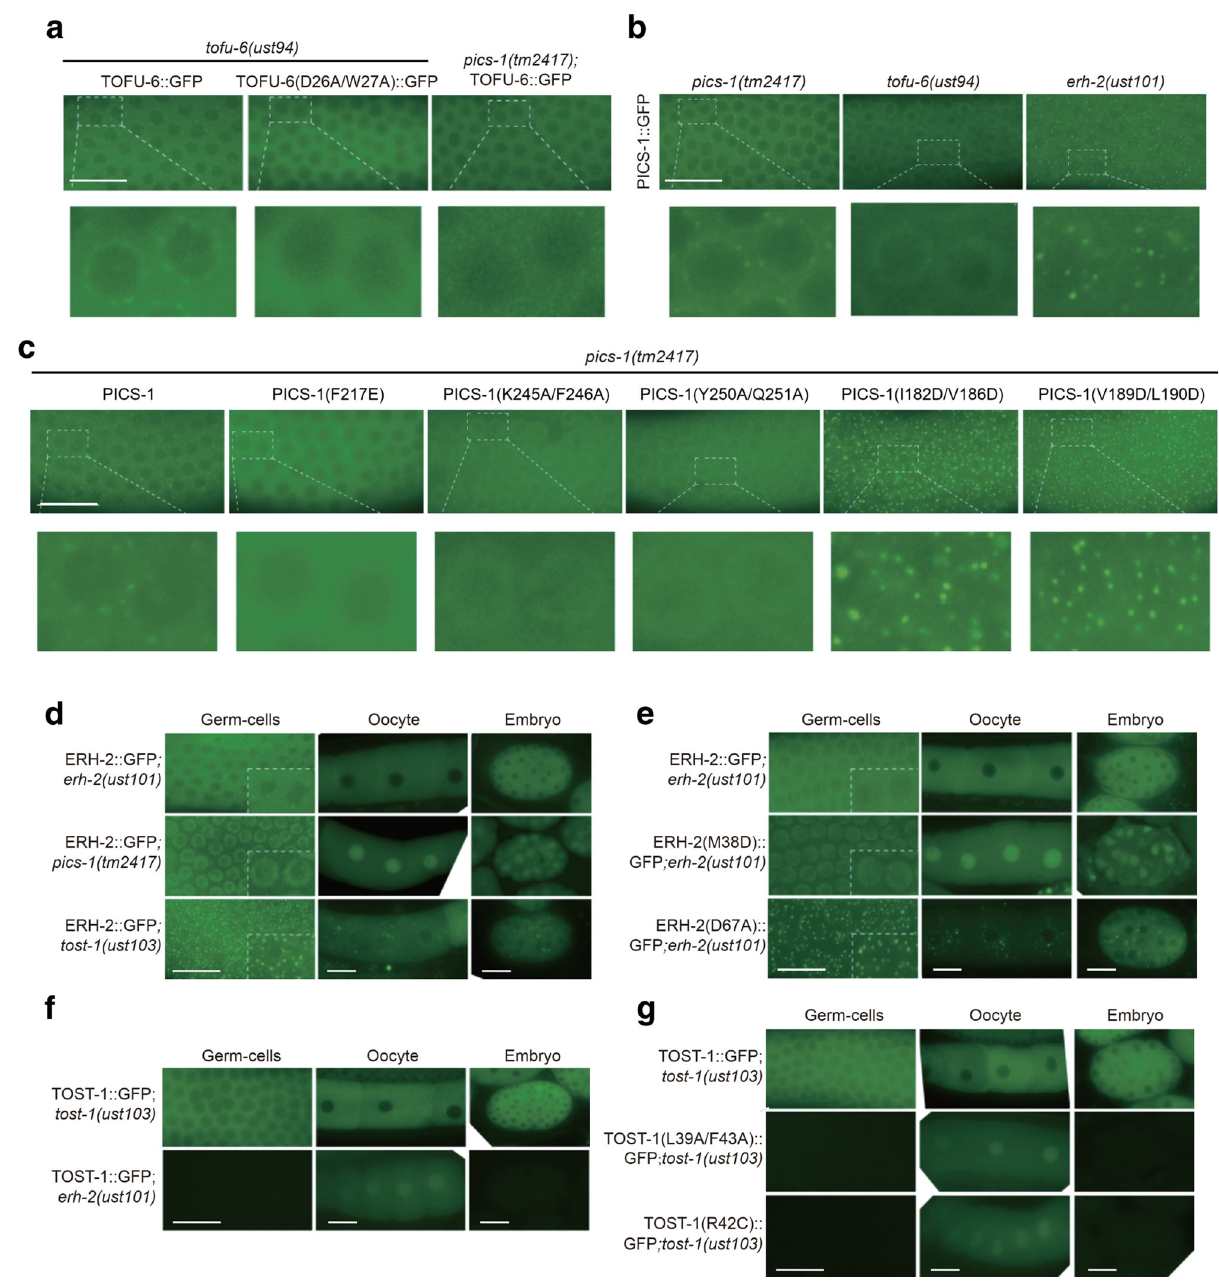
Fig. 5 PICS promoting 21U RNAs biogenesis are dependent of the interactions of PICS subunits. a Images of adult germline cells expressing GFP tagged- TOFU-6 or TOFU-6 D26A/W27A in indicated mutant backgrounds. TOFU-6 D26A/W27A impairs the interaction between TOFU-6 and PICS-1(PID-3). b Images of adult germline cells expressing GFP tagged- PICS-1(PID-3) in indicated mutant backgrounds. c Images of adult germline cells expressing GFP tagged wild-type or amino acids- substituted PICS-1(PID-3) in pics-1 (tm2417) background. K245A/F246A and Y250A/Q251A of PICS-1(PID-3) weaken the interaction with TOFU-6 . F217E disrupts the homodimerization of PICS-1(PID-3). I182D/V186D and V189D/L190D of PICS-1(PID-3) disrupt the interaction with ERH-2. d Images of adult germline cells, oocytes and embryos expressing GFP tagged ERH-2 in indicated mutant backgrounds. e Images of adult germline cells, oocytes and embryos expressing GFP tagged wild-type or amino acids- substituted ERH-2 in erh-2 null mutant background. ERH-2 M38D disrupts the interaction with PICS-1(PID-3) . ERH-2 D67A disrupts the interaction with TOST-1. f Images of adult germline cells, oocytes and embryos expressing GFP tagged TOST-1 in indicated mutant backgrounds. g Images of adult germline cells, oocytes and embryos expressing GFP tagged wild-type or amino acids- substituted TOST-1 in tost-1 null mutant background. L39A/F43A and R42C of TOST-1 disrupt the interaction with ERH-2. Scale bars, 20 μ m. The worms were harvested once, while the imaging experiments were